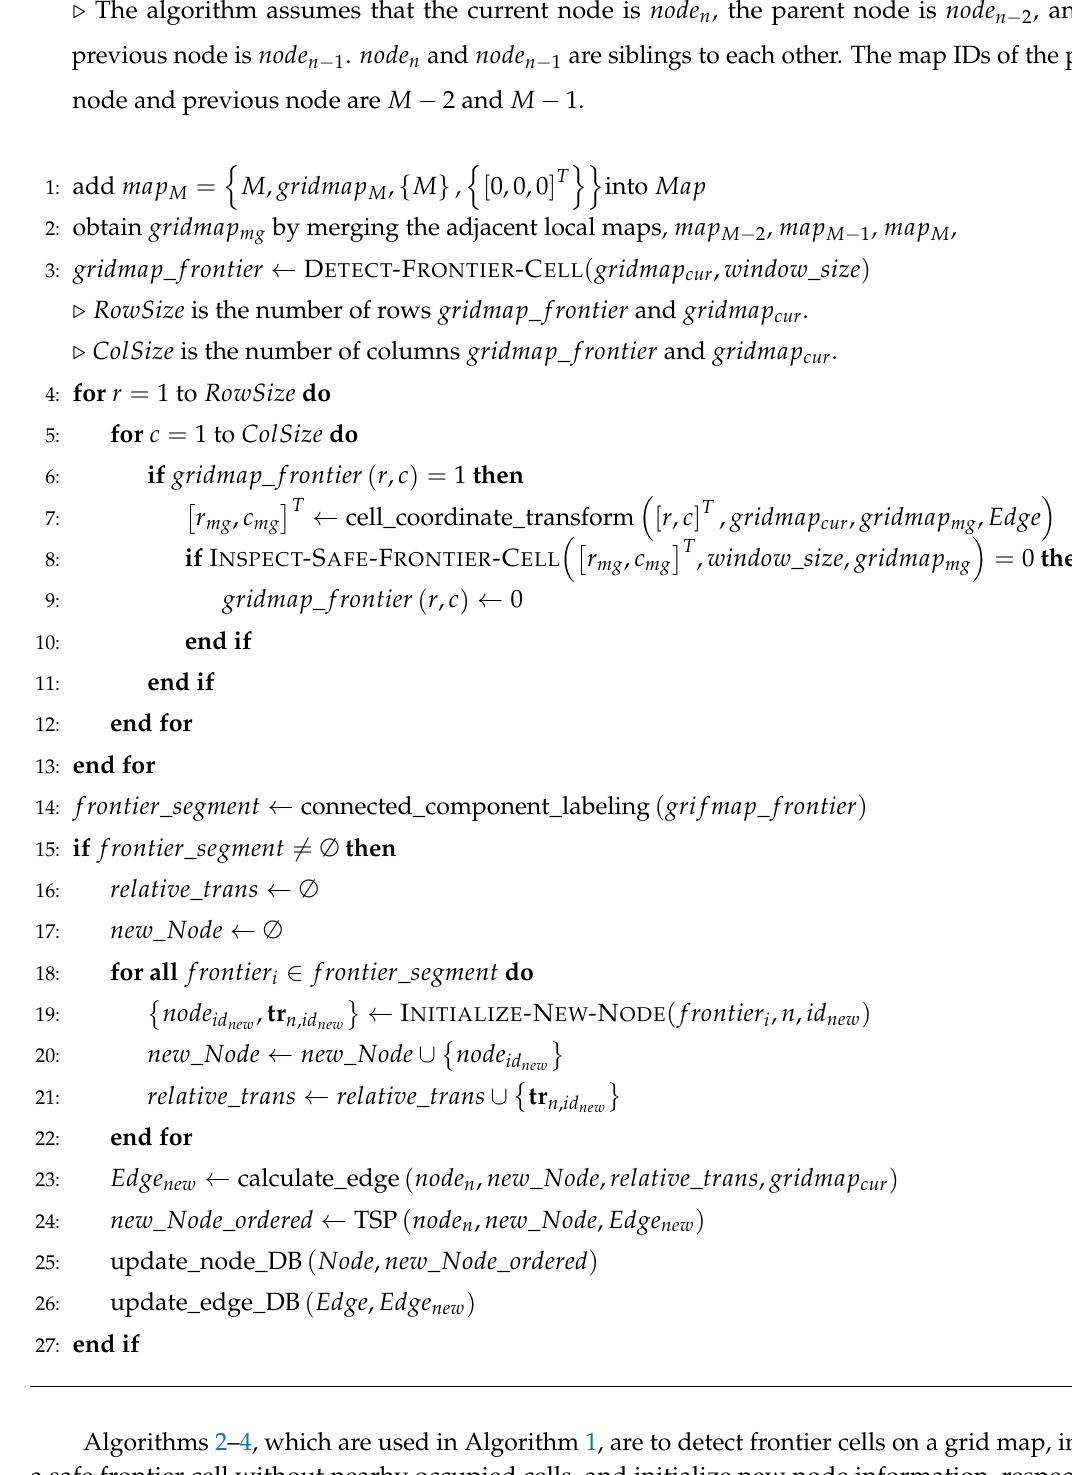
Algorithm 1 Registration of new nodes by frontier segmentation